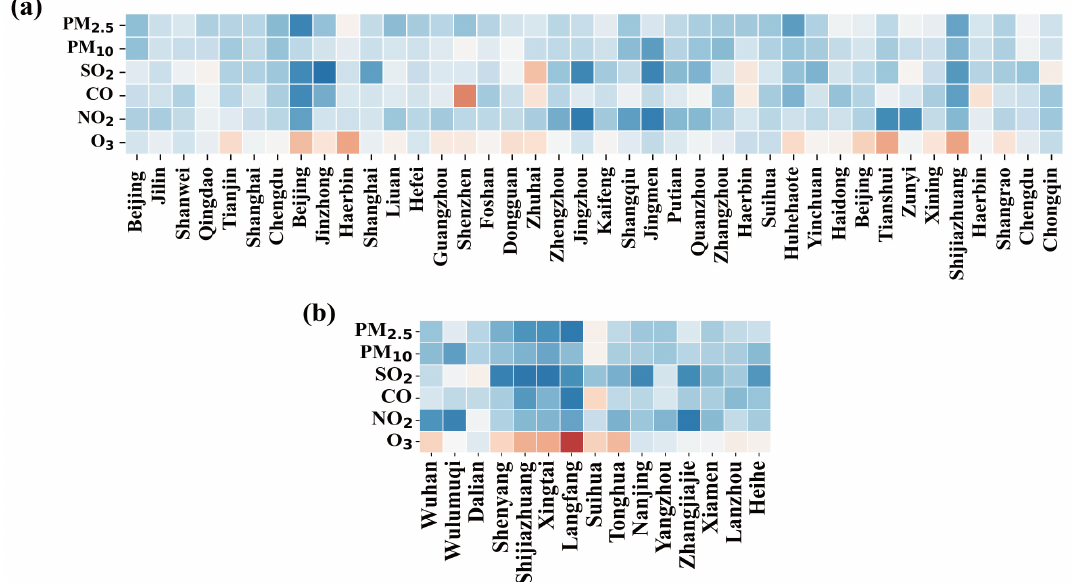
Figure 2. The relative difference between the concentration of PM 2.5 , PM 10 , NO 2 , SO 2 , CO and O 3 during the lockdown period, and the same period from 2017 to 2019, in 55 cities: ( a ) semi-lockdown ( b ) full lockdown.